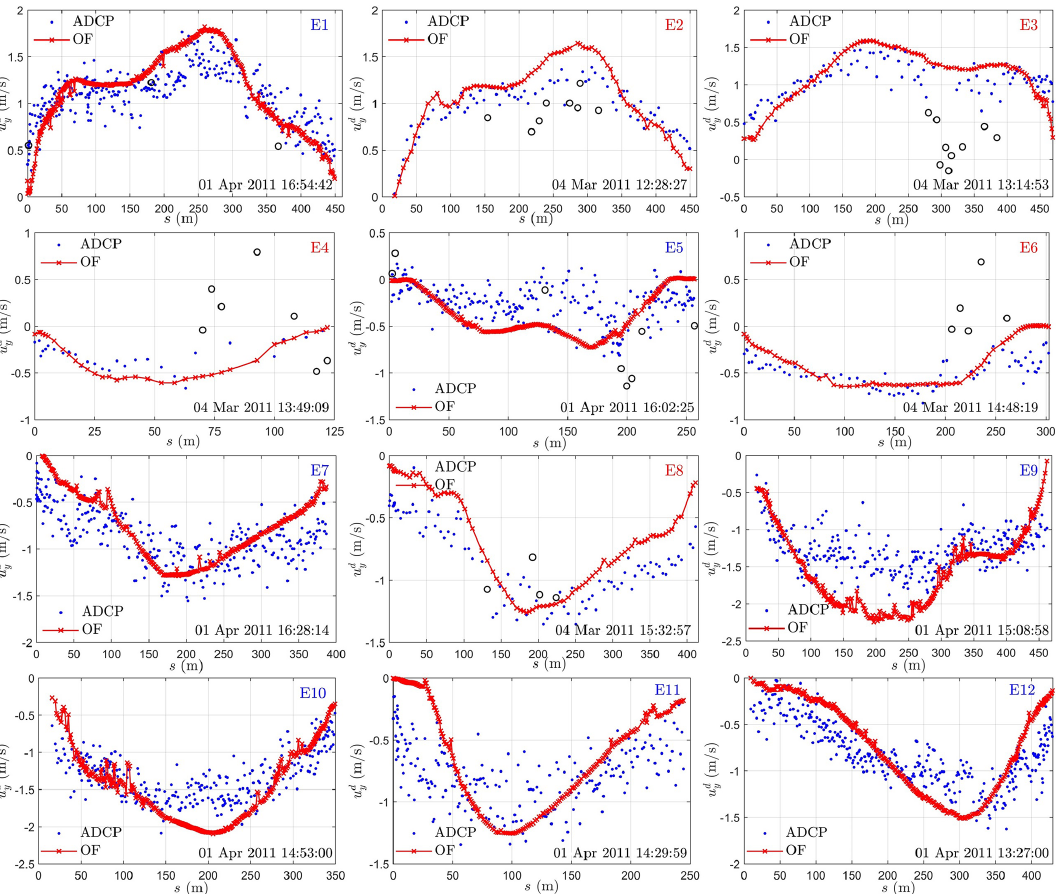
Figure A6. A comparison of depth-averaged velocity component along y from ADCP surveys and CFD modeling at E1–E12. Black circles denote measured outliers visually determined from Fig. A5 or Fig. A6.